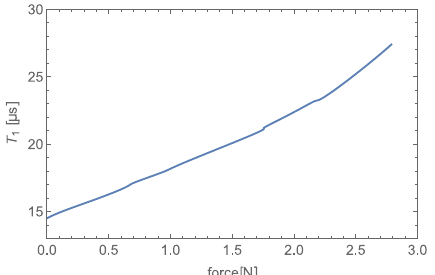
Figure 17. Transfer characteristics of the experimental transducer of a single-component